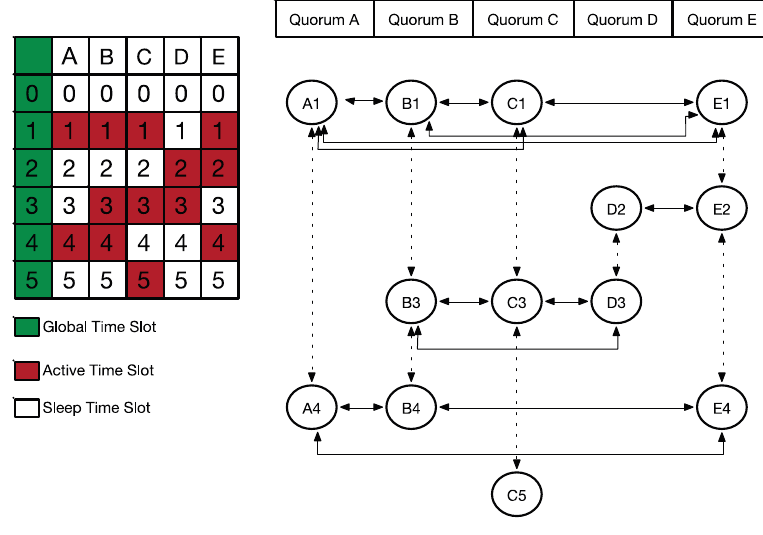
Figure 4. Example of our proposed WQS